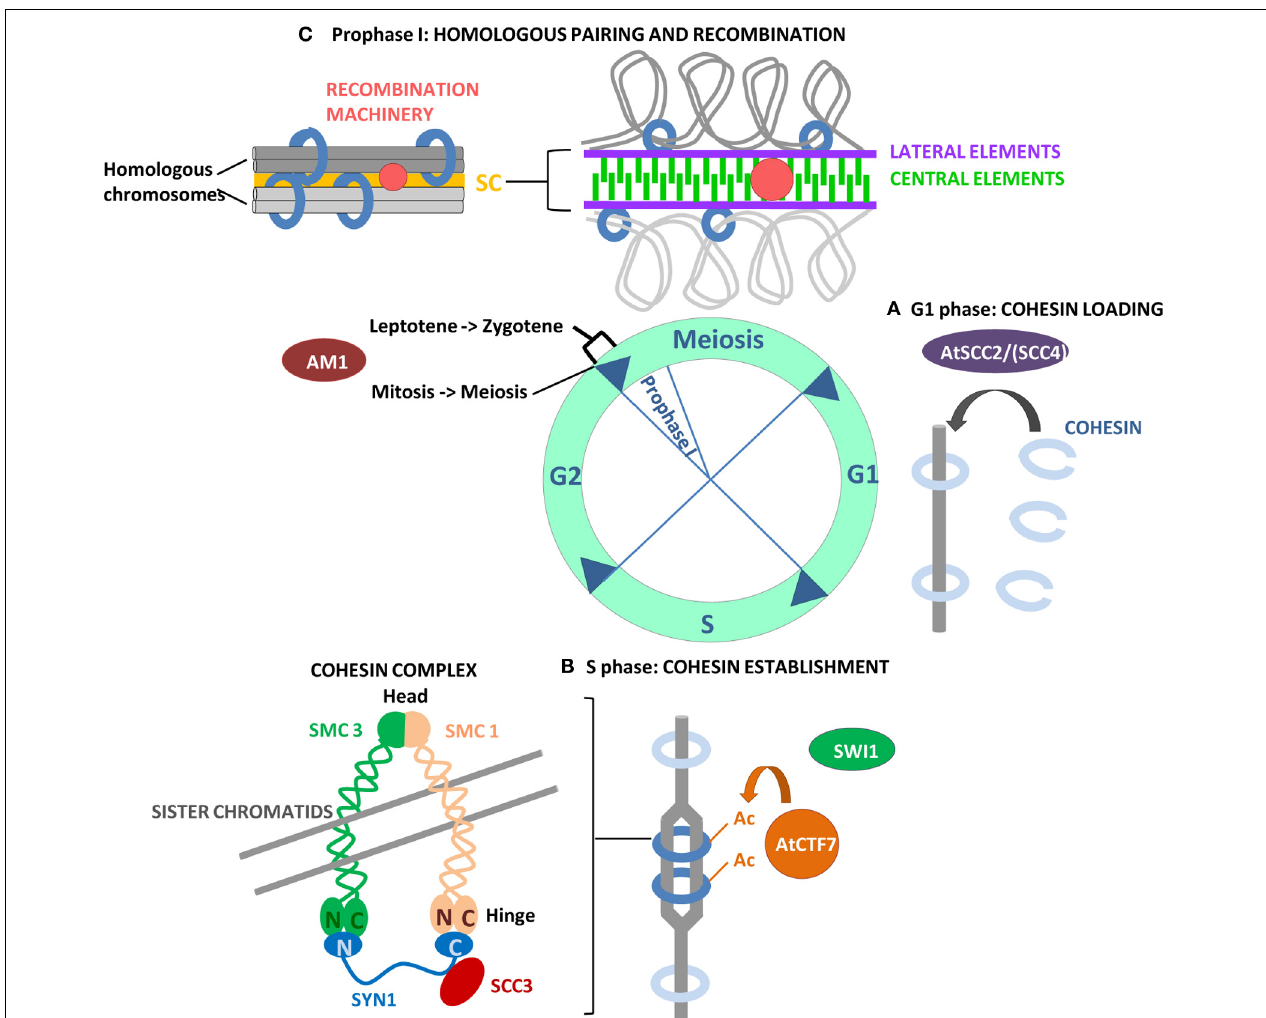
FIGURE 1 | Overview of the events that allow the establishment of the cohesin complex on chromosomes, necessary for the successive steps of chromosome segregation, including homologous pairing and recombination in meiosis I. (A) Loading of cohesin on chromosomes requires the SCC2/SCC4 complex, only AtSCC2 has been characterized in Arabidopsis . (B) The establishment of chromosome cohesion takes place during DNA replication in S phase when Eco1/CTF7 acetylates SMC3 residues, effectively closing the cohesin